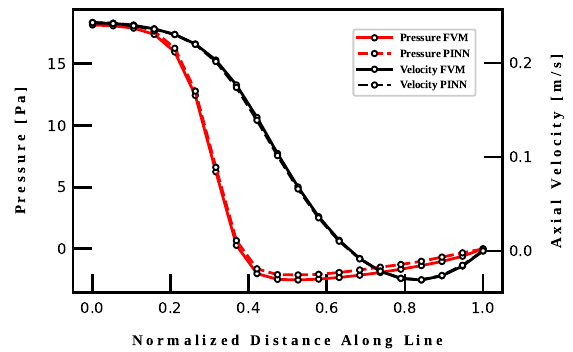
Figure 11. Section plot for the laminar solution at a valve angle of 45 ◦ ; the pressure profile along the symmetry plane is in red, and the axial velocity profile downstream of the valve is in